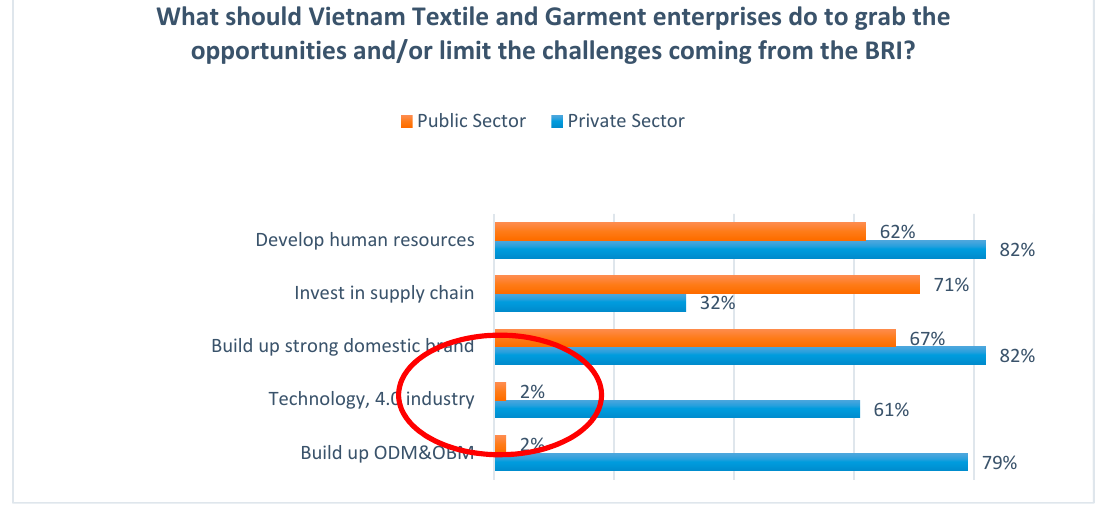
Figure 7. Expected actions taken by Vietnam (Source: Authors’ analysis).